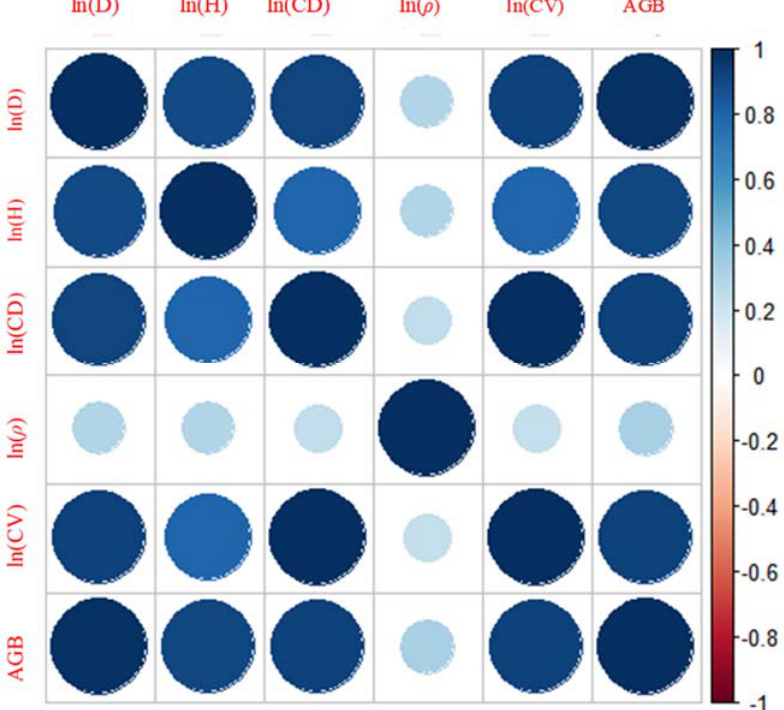
Figure 2. Positive correlation between response variable AGB and natural logarithm of five predicted variables D, H, CD, ρ and CV with Spearman rank correlation from − 1 to +1. The color intensity and the size of the circle are proportional to the correlation coefficients.